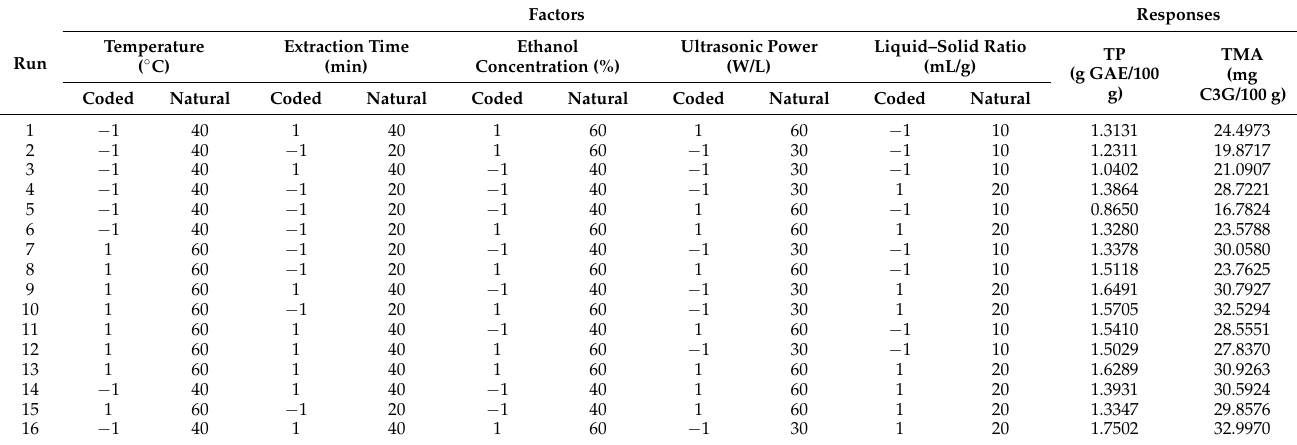
Table 1. Applied 2 5-1 -factorial design for screening the factors of UAE that affect total phenols content (TP) and total monomeric anthocyanins